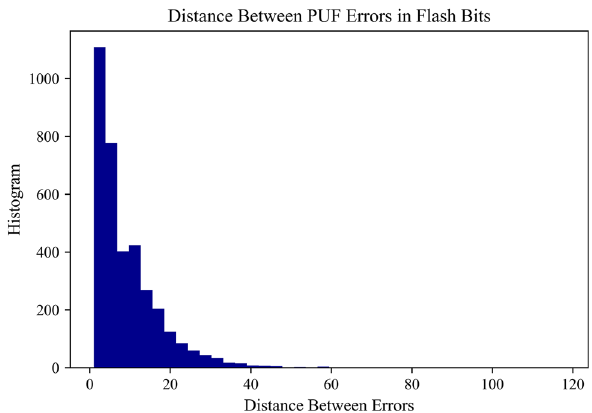
Fig. 5 Histogram of distance between sequential